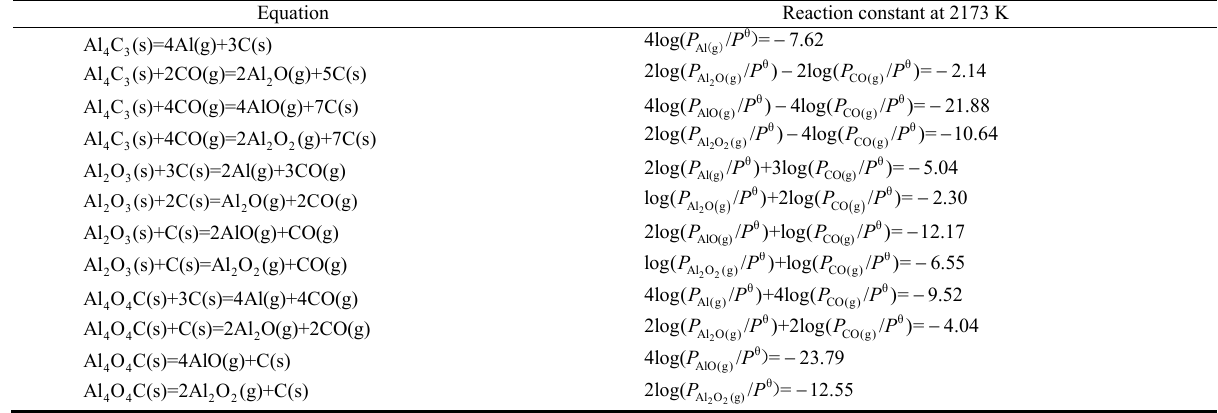
Table 2 Reactions and related thermodynamic data in the Al  O  C system at 2173 K Equation Reaction constant at 2173